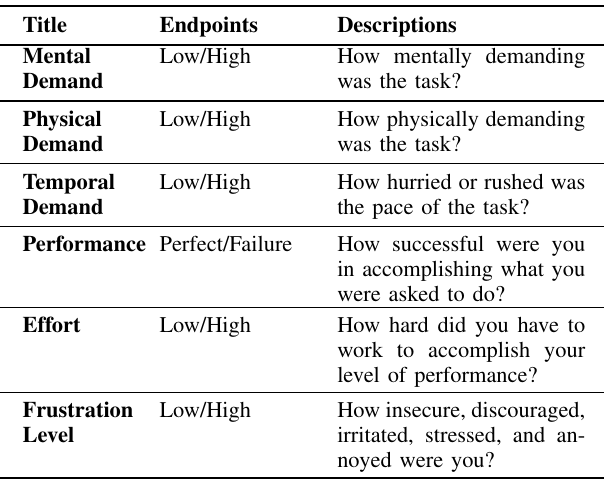
TABLE I R ATING SCALE DEFINITIONS AND ENDPOINTS FROM THE NASA-TLX